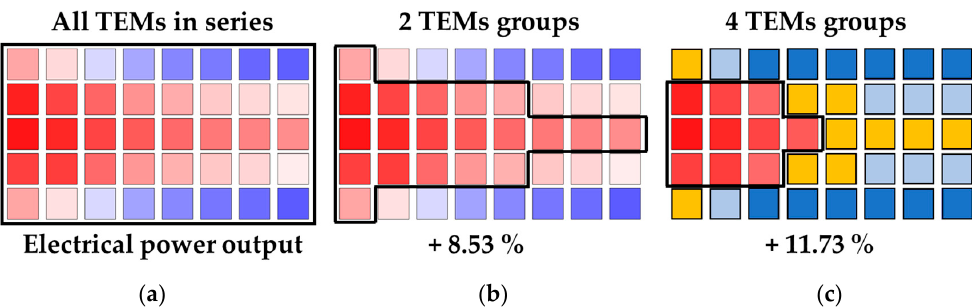
Figure 13. Comparison of the electric energy generated by the TEG depending on the connection of the TEMs: ( a ) all TEMs in series, ( b ) 2 TEM groups, and ( c ) 4 TEM groups.